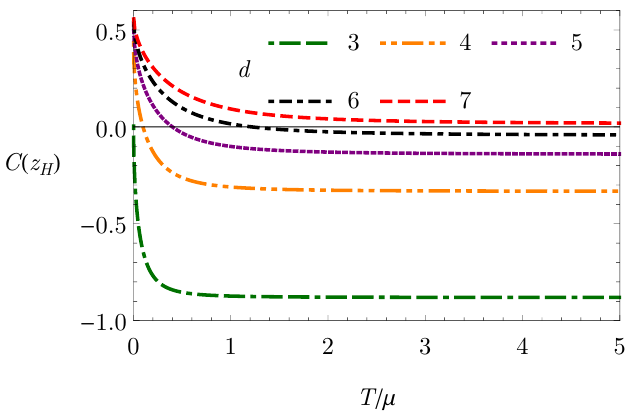
Figure 11. The dimensionless coe(cid:14)cient C ( z H ) from eq. (2.23) versus T=(cid:22) for AdS-RN,